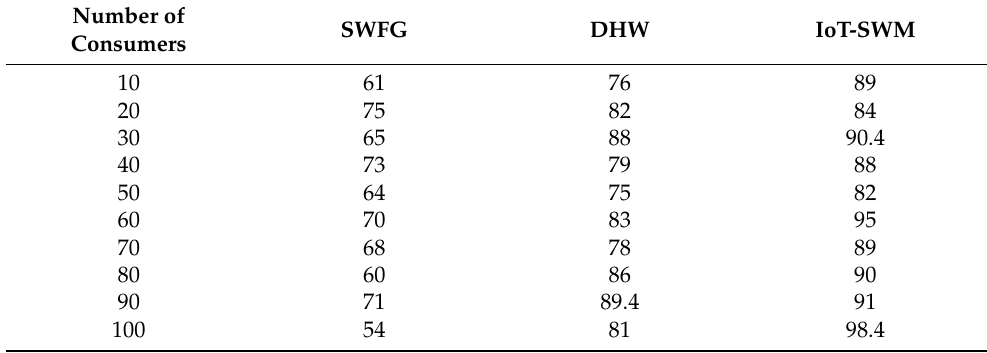
Table 5. Analyzing non-revenue water